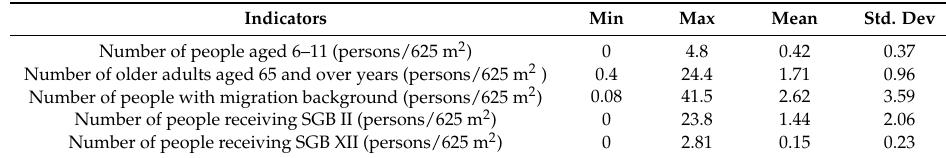
Table 7. Descriptive statistics for indicators of social vulnerability at the level of social units.